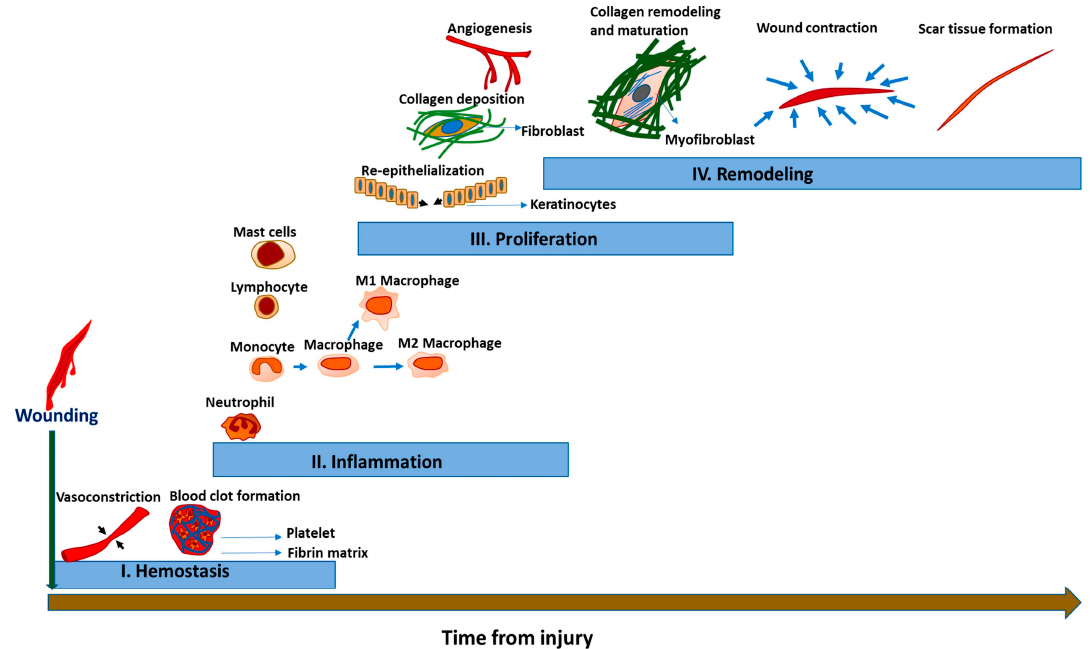
Figure 1. The phases of acute wound healing, including hemostasis (I), inflammation (II), proliferation (III), and remodeling (IV). Hemostasis begins soon after wounding with vasoconstriction and blood clot formation. This is followed by the infiltration of inflammatory cells. Then, re-epithelialization occurs with collagen deposition and angiogenesis during the proliferation phase. Finally, the remodeling phase occurs with collagen remodeling and maturation, wound contraction, and scar tissue formation.